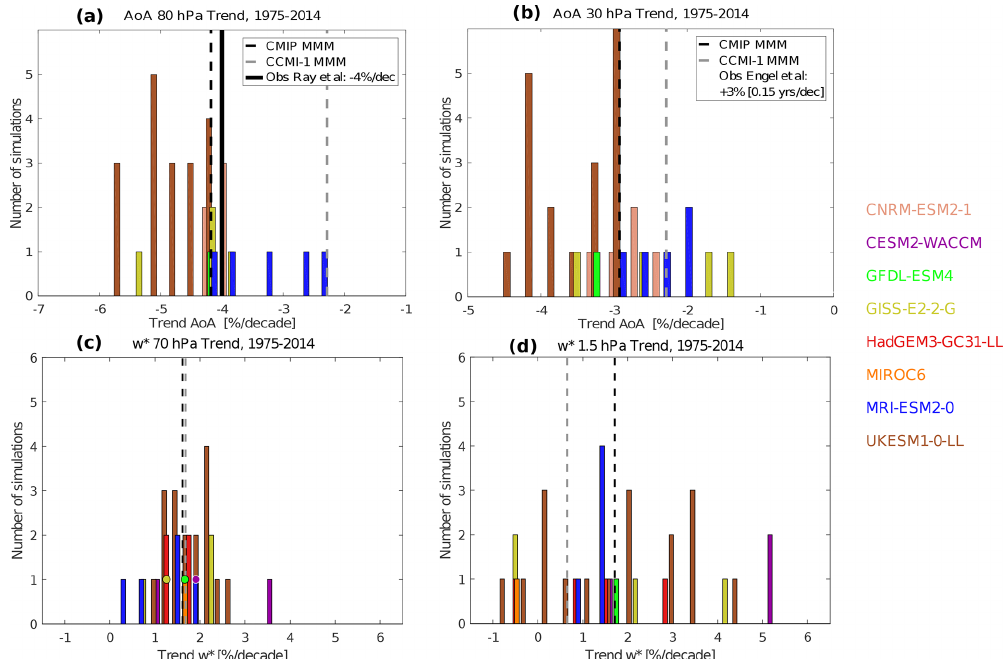
Figure 5. Absolute frequency distribution of trends (in % per decade) over 1975–2014 from individual models and ensemble members in AoA at 80hPa (a) and 30hPa (b) averaged over 30–45 ◦ N and in tropical upwelling at 70hPa (c) and 1.5hPa (d) . In panel (a) the observational trend estimate at 80hPa over 1975–2012 from Ray et al. (2014) updated for the 2018 WMO ozone assessment report (Karpechko et al., 2018) is included as a black solid line. In panel (b) , the observational trend estimate at 30hPa over 1975–2017 from Engel et al. (2017) is only shown in the legend, as the value is positive and thus outside the scale. Dashed lines show the MMM for CMIP6 models (black) and for CCMI models (gray). In panel (c) a colored circle is shown where a bar is covered by another model’s bar. The number of available members from the historical simulations is 5 for CRNM-ESM2-1, 3 for CESM2-WACCM, 1 for GFDL-ESM4, 4 for GISS-E2-2-G, 4